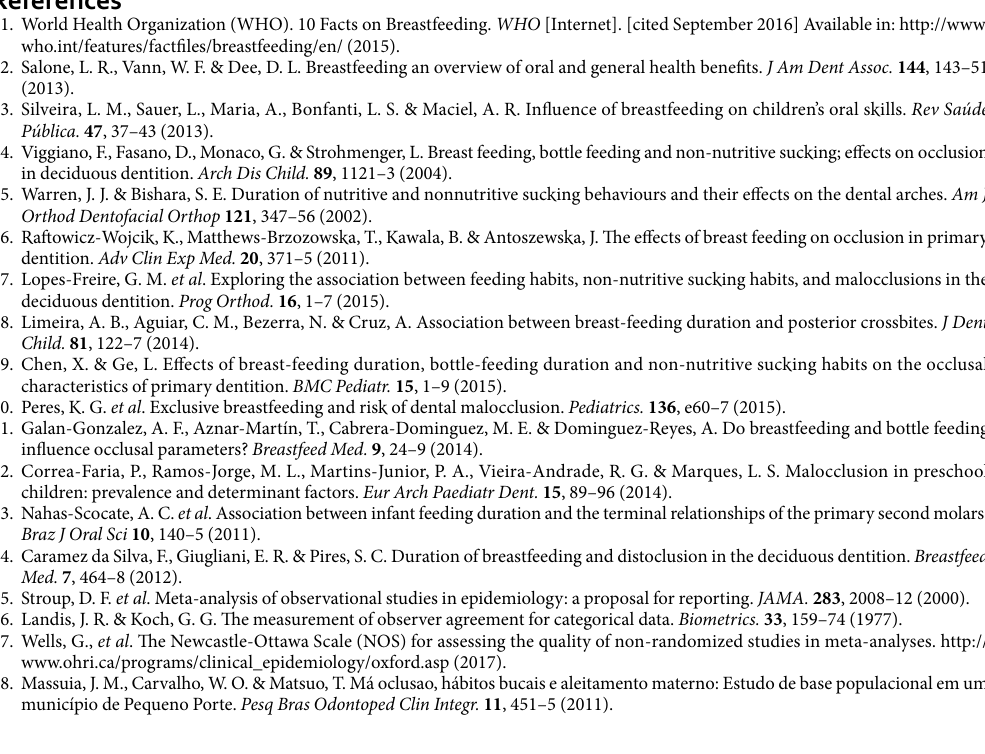
10 Scientific RepoRts | 7: 5048 | DOI:10.1038/s41598-017-05393-y